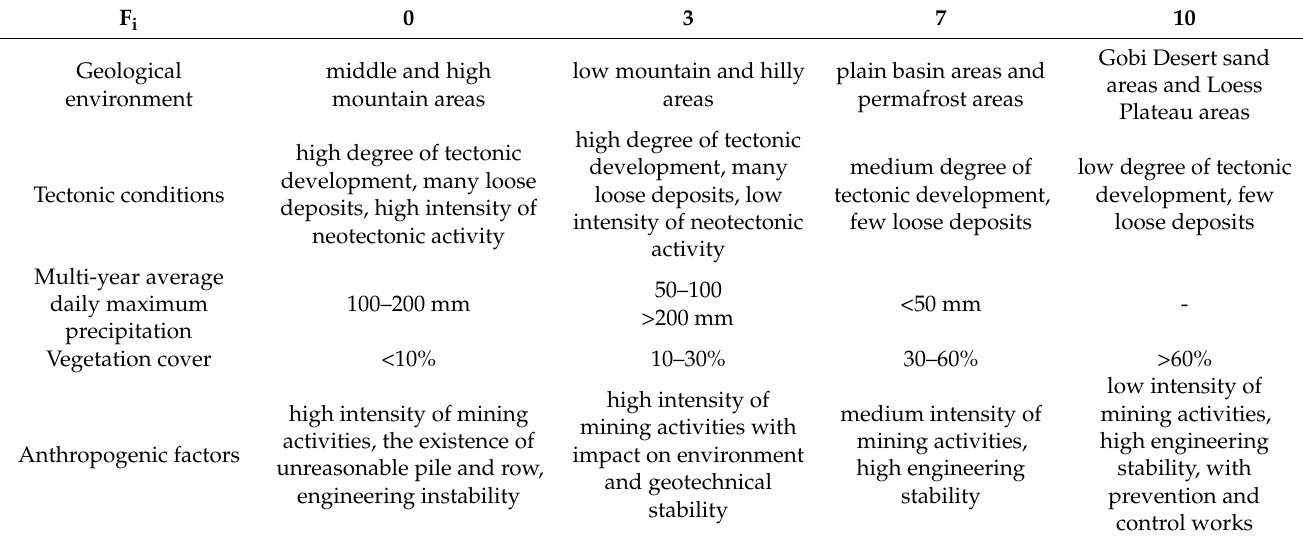
Table 5. Rating factor